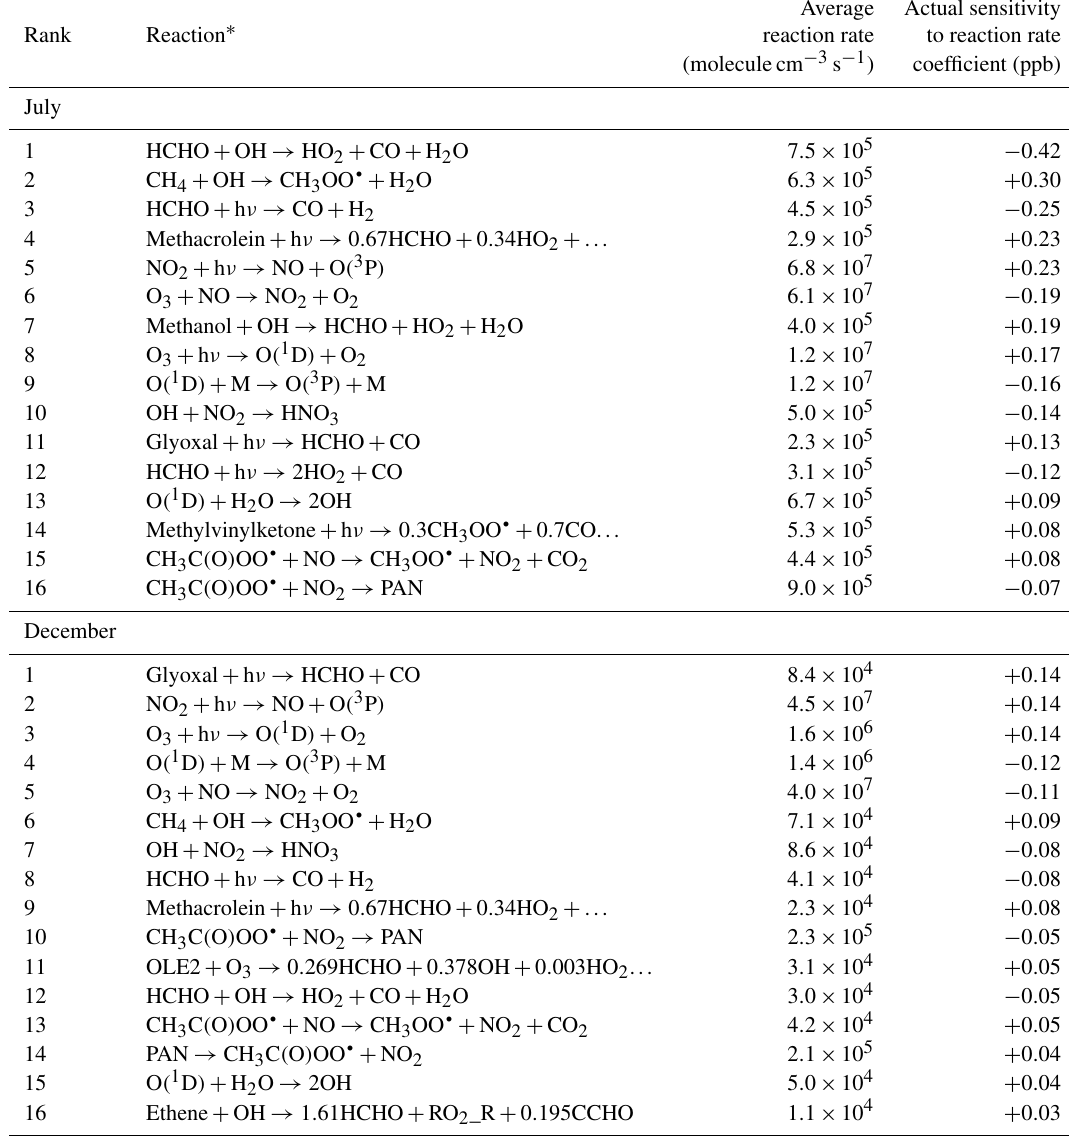
Table 4. Reaction rates (averaged over the modeling domain and simulation period) and semi-normalized sensitivities S × modeling domain and simulation period) of the air-basin-wide response to reaction rate coefficients for the 16 reactions for which S × the largest magnitude. Reactions are ranked separately for each